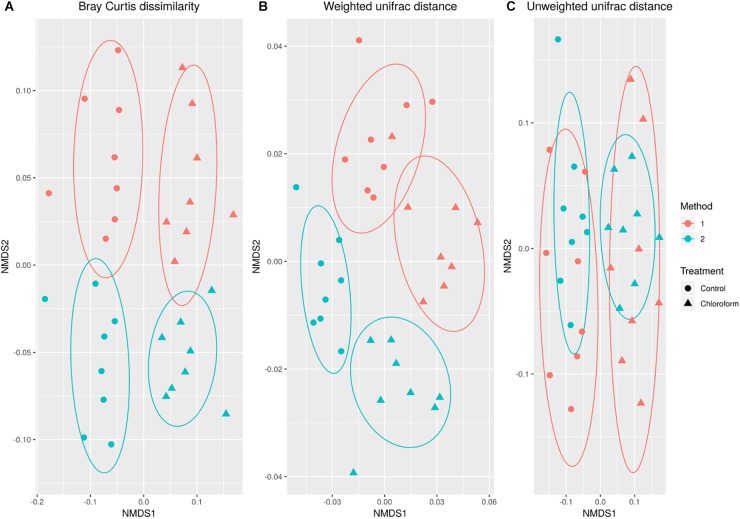
Non-metric MultiDimensional Scaling ordination comparing changes in microbial operational taxonomic unit (OTU) classification based on Bray-Curtis dissimilarity (A), weighted (B) and unweighted (C) UniFrac calculations for control (•) and chloroform () treatments at Method 1 (red) and Method 2 (light green).